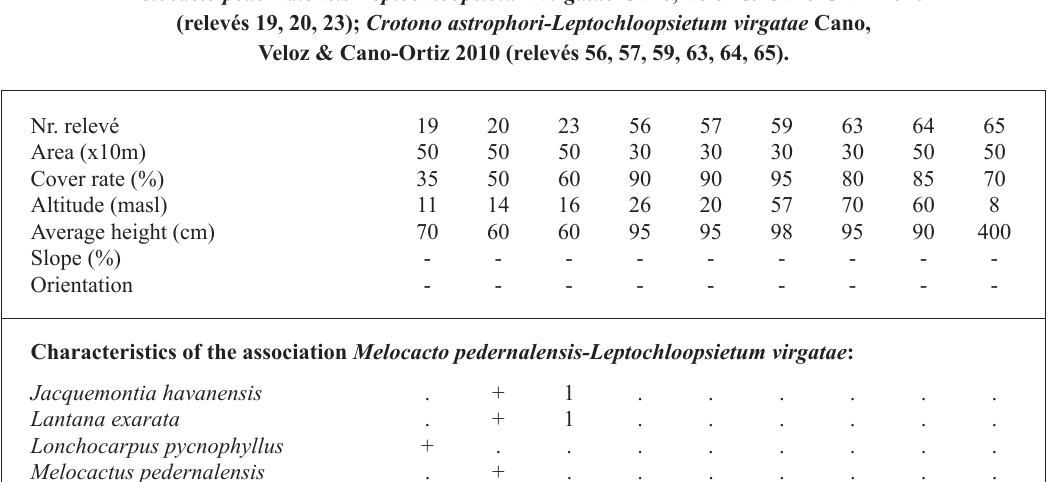
Melocacto pedernalensis-Leptochloopsietum virgatae Cano, Veloz & Cano-Ortiz